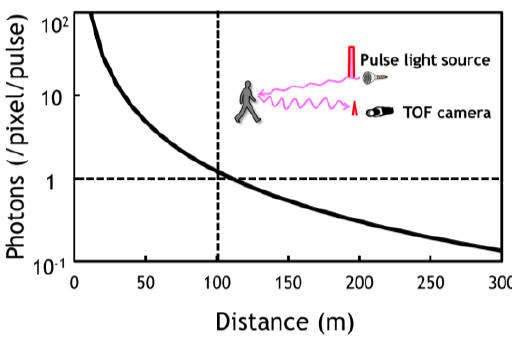
Figure 2. Average photon numbers per pixel per pulse reflected from an object as a function of distance (d) between a time-of-flight (TOF) system and the object showing its dependence on d −2 . It is noted that, beyond 100 m, the average photon number falls below unity as specified by dotted lines. The assumptions made are: (1) a 10 ns pulse laser source with the peak power of 1.2 kW; (2) a field of view of 20 degrees; and (3) a 10% reflectance of an object.